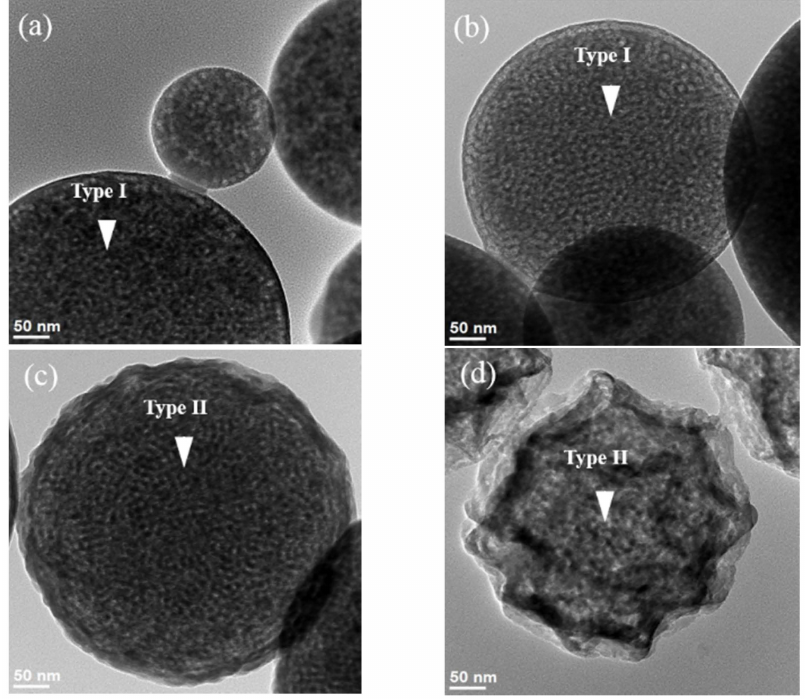
Figure 3. TEM images of MBG particles prepared using various surfactant concentrations of ( a ) 14 wt %; ( b ) 31 wt %; ( c ) 44 wt %; and ( d ) 53 wt